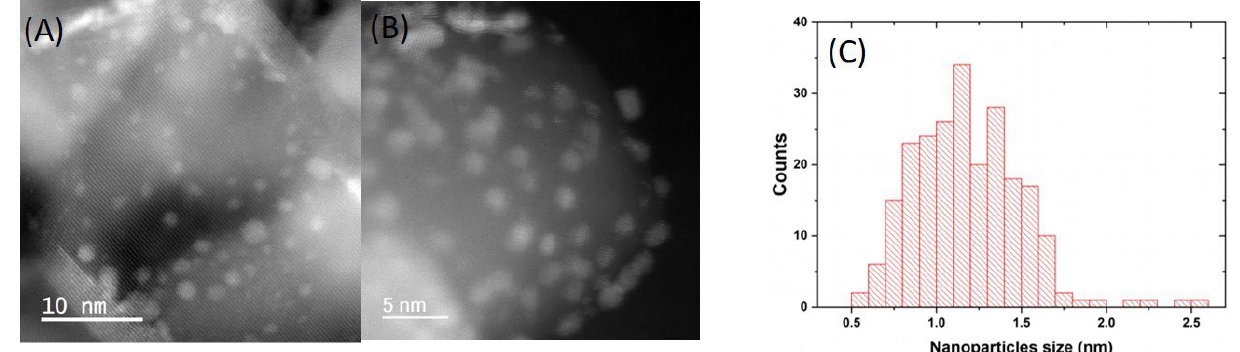
Figure 2. ( A , B ) HAADF-STEM images of the 1.3 wt.% Pt/TiO 2 and ( C ) corresponding particle size distribution.